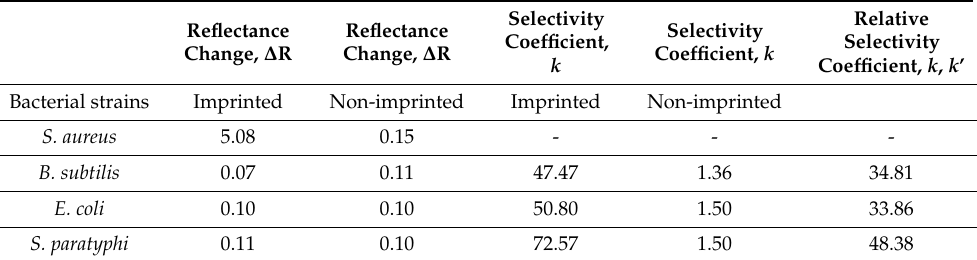
Figure 5. ( a ) Imprinting efficiency of MIP-SPR vs. NIP-SPR sensor chips ( b ) Selectivity of the S. aureus imprinted SPR sensor chips against competitor bacterial strains. Table 1. Selectivity coefficients of S. aureus imprinted and non-imprinted SPR chips, k : selectivity coefficient for S. aureus versus competing bacterial strains, k ’: relative selectivity coefficient for S. aureus -imprinted SPR chip versus non- imprinted SPR